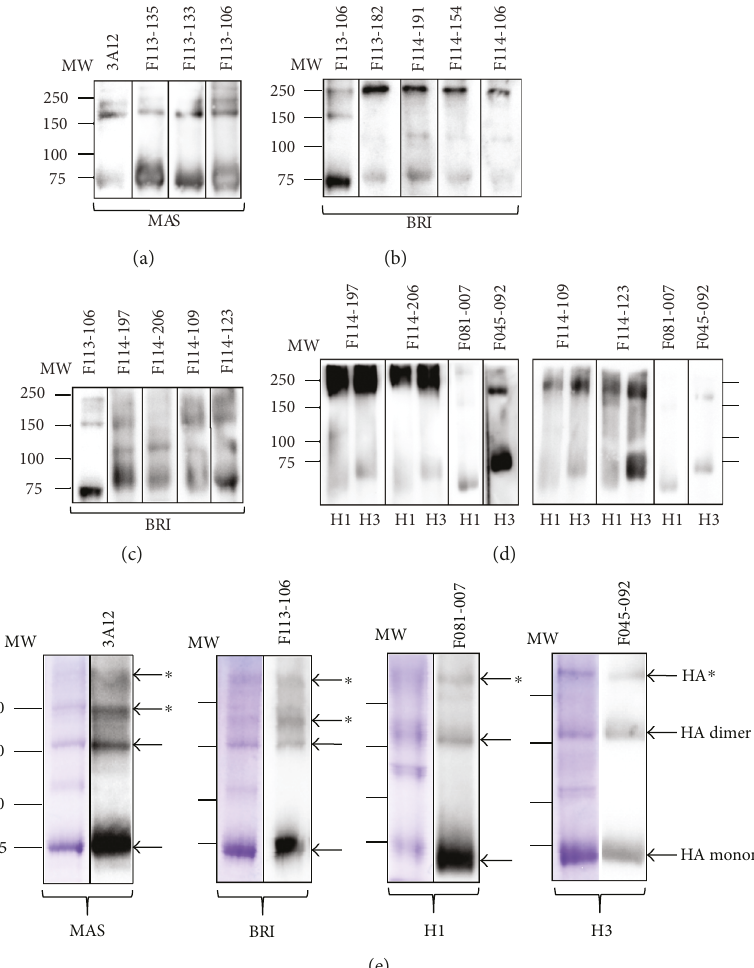
Figure 5: Western blotting analysis of representative Abs against in fl uenza B and A virus strains. (a) Three Abs that showed HI activity. Mouse mAb 3A12 was used as a positive control against in fl uenza B/MAS. (b) Four Abs belonging to type 2. (c, d) Four Abs belonging to type 3. (d) F045-092 and F081-007 were used as a positive control against in fl uenza A/H3N2 and in fl uenza A/H1N1, respectively. (e) Left lane, HA-enriched fraction of virus particles was applied and stained with CBB. Right lane, Western blotting with four mAbs. HA ∗ , the position of HA monomer and dimer were clear. However, while HA should be included in the upper bands, it is possible that something other than HA molecule is